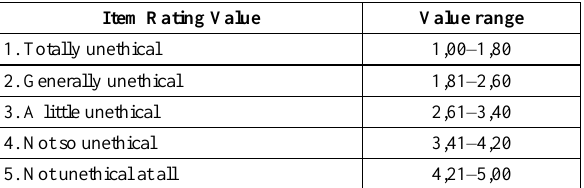
Table 3. Item evaluation